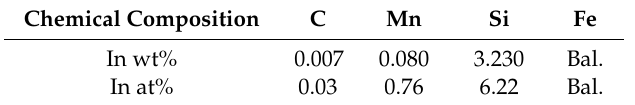
Table 1. Chemical composition of the investigated grain-oriented electrical steel (GOES).